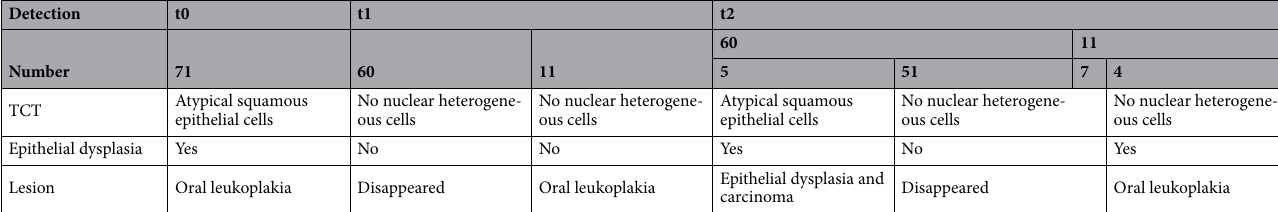
Table 3. Follow-up effects of YSGG-PDT